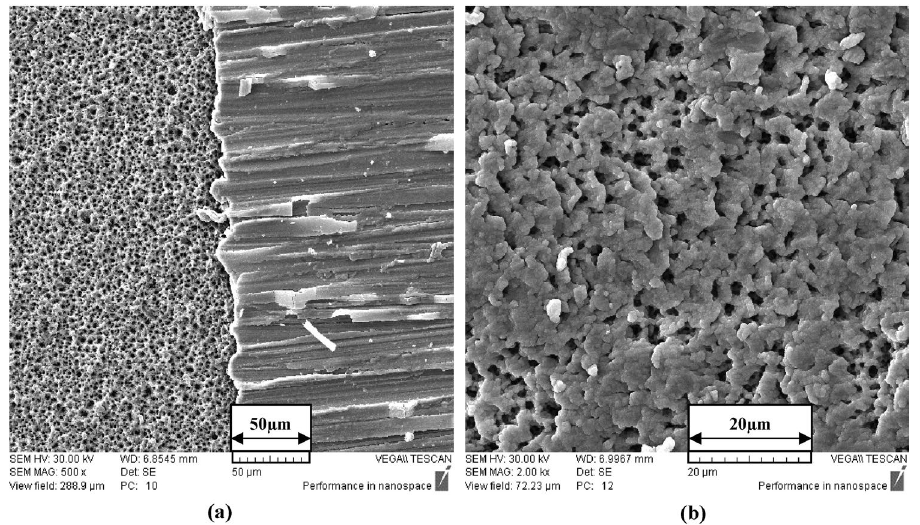
Figure 3. SEM image of flexible UV PDs based on ZnO on the fiberglass (FR4) substrateat (a) at × 500 magnification of electrode and ZnO together, (b) at × 2 K magnification of